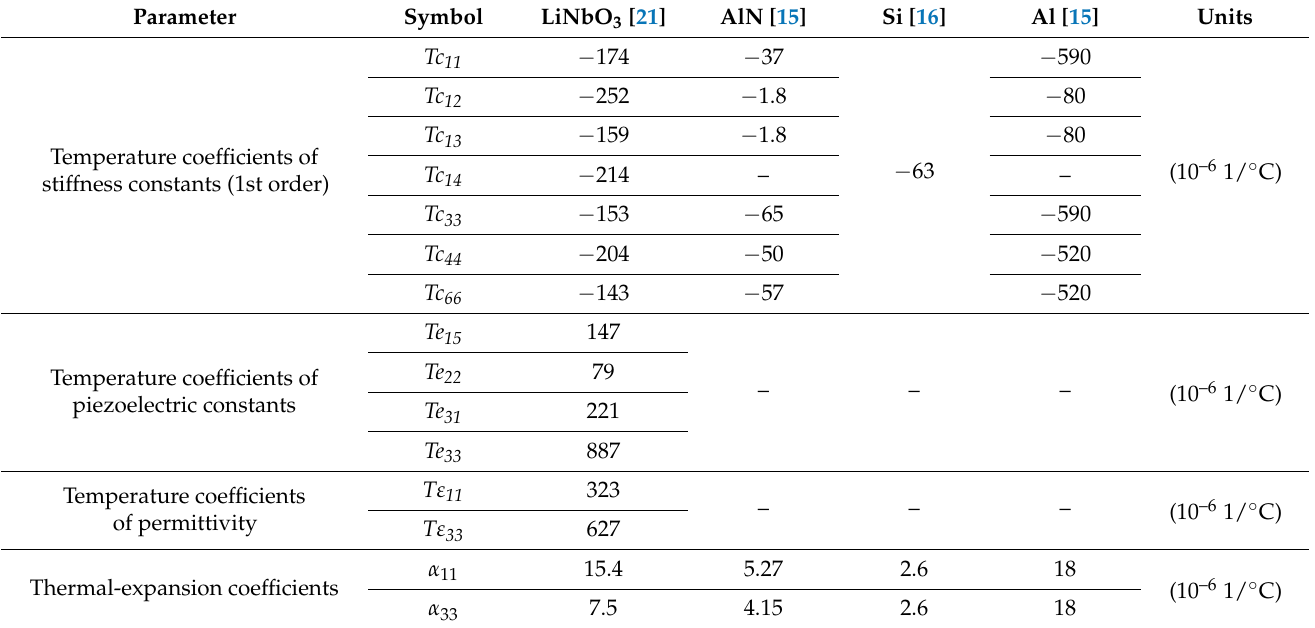
Table 3. Temperature coefficients of material constants of LiNbO 3 , AlN, Si, and Al used in the simulations